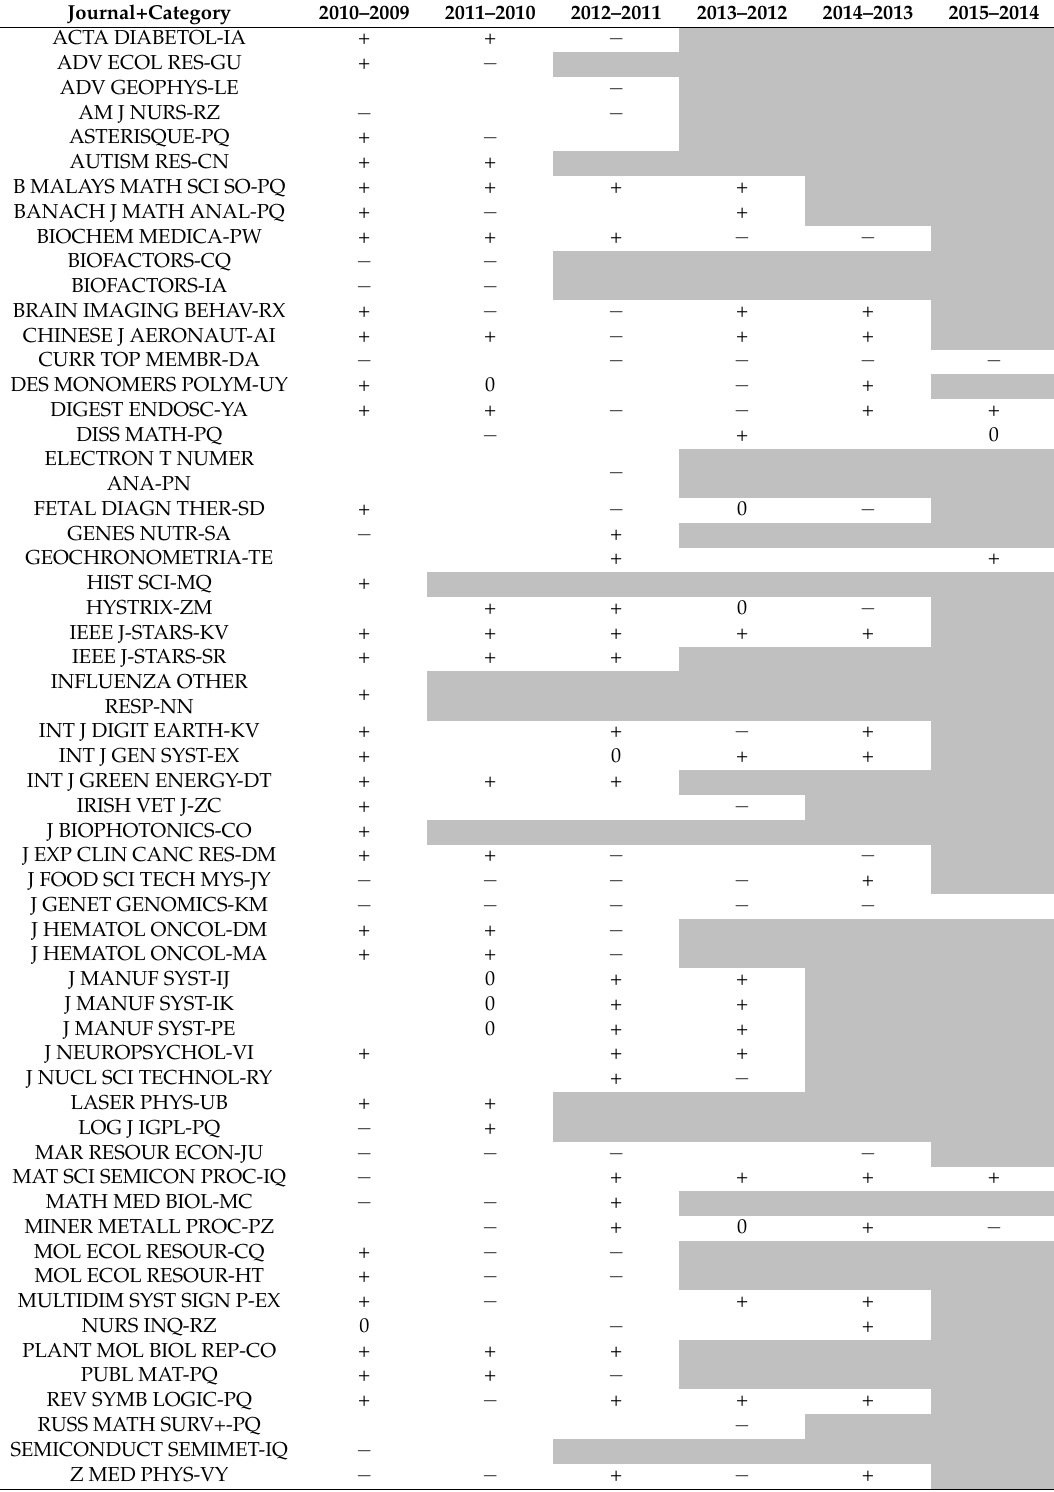
Table 3. Transitions in which the citations used to compute the JIF increased. +: the JIF denominator increased; 0: the JIF denominator did not change; − : the JIF denominator decreased. Gray cells represent years outside the range of study. Empty cells represent transitions that did not involve increased citations used to compute the